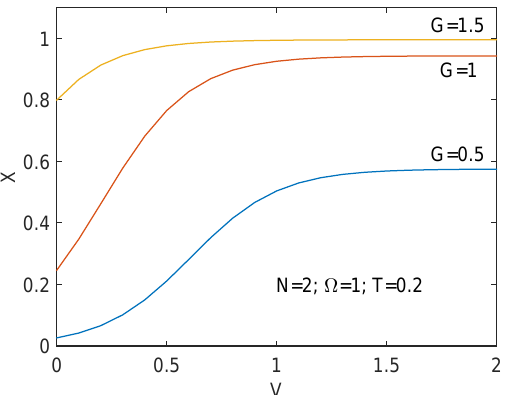
Figure 1. Superconductivity indicator X versus monopole coupling constant (cc) V for various values of the paring cc G . We have N = 2 and T = 0.2 Remember that the pairing’s cc at T = 0 is G crit = 1.